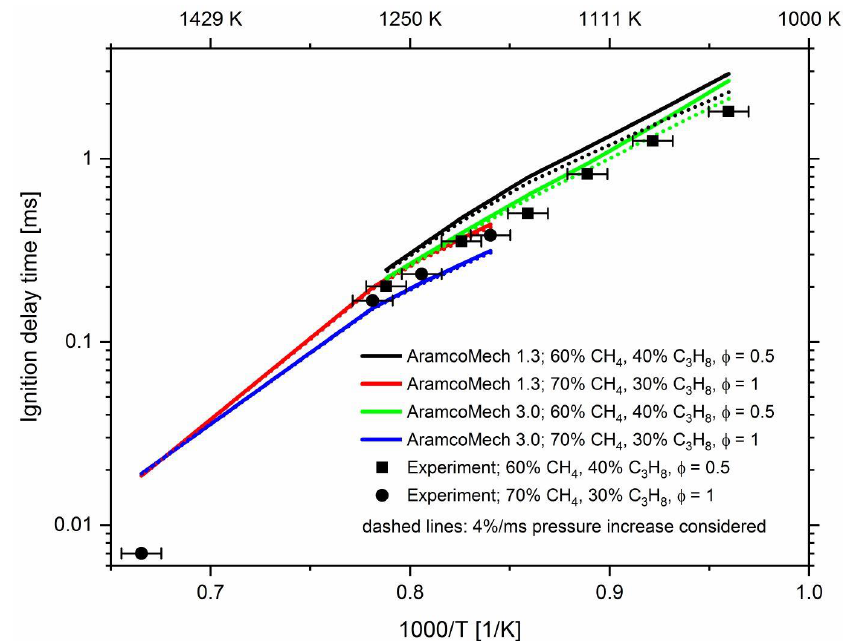
Figure 8. Comparison of calculated IDT considering a pressure increase of 4%/ms as well as no increase using the mechanisms AramcoMech 1.3 and 3.0 with experimental ST data published by Petersen et al. [51].